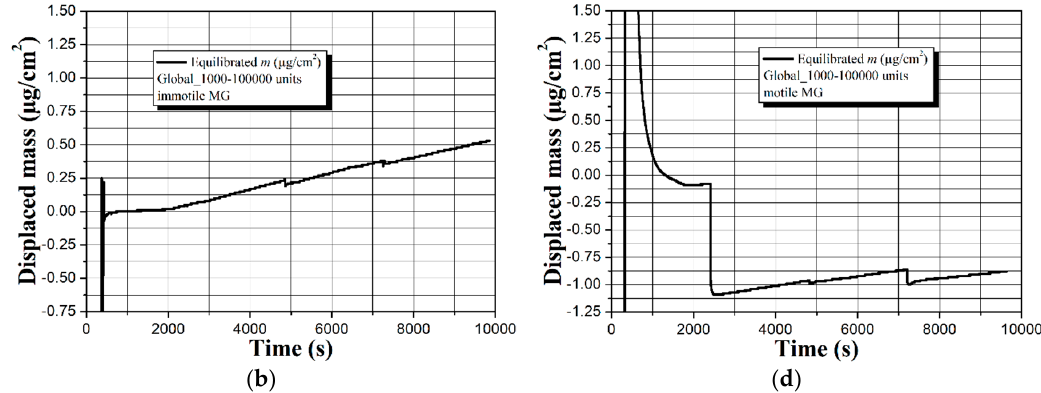
Figure 7. Real-time sensor response of a soot coated 5 MHz QCM to ( a , b ) immotile and ( c , d ) progressively motile human spermatozoa with gradually increasing concentration. All graphs reflect actual biomass effects after equilibration of the baselines in Global medium.